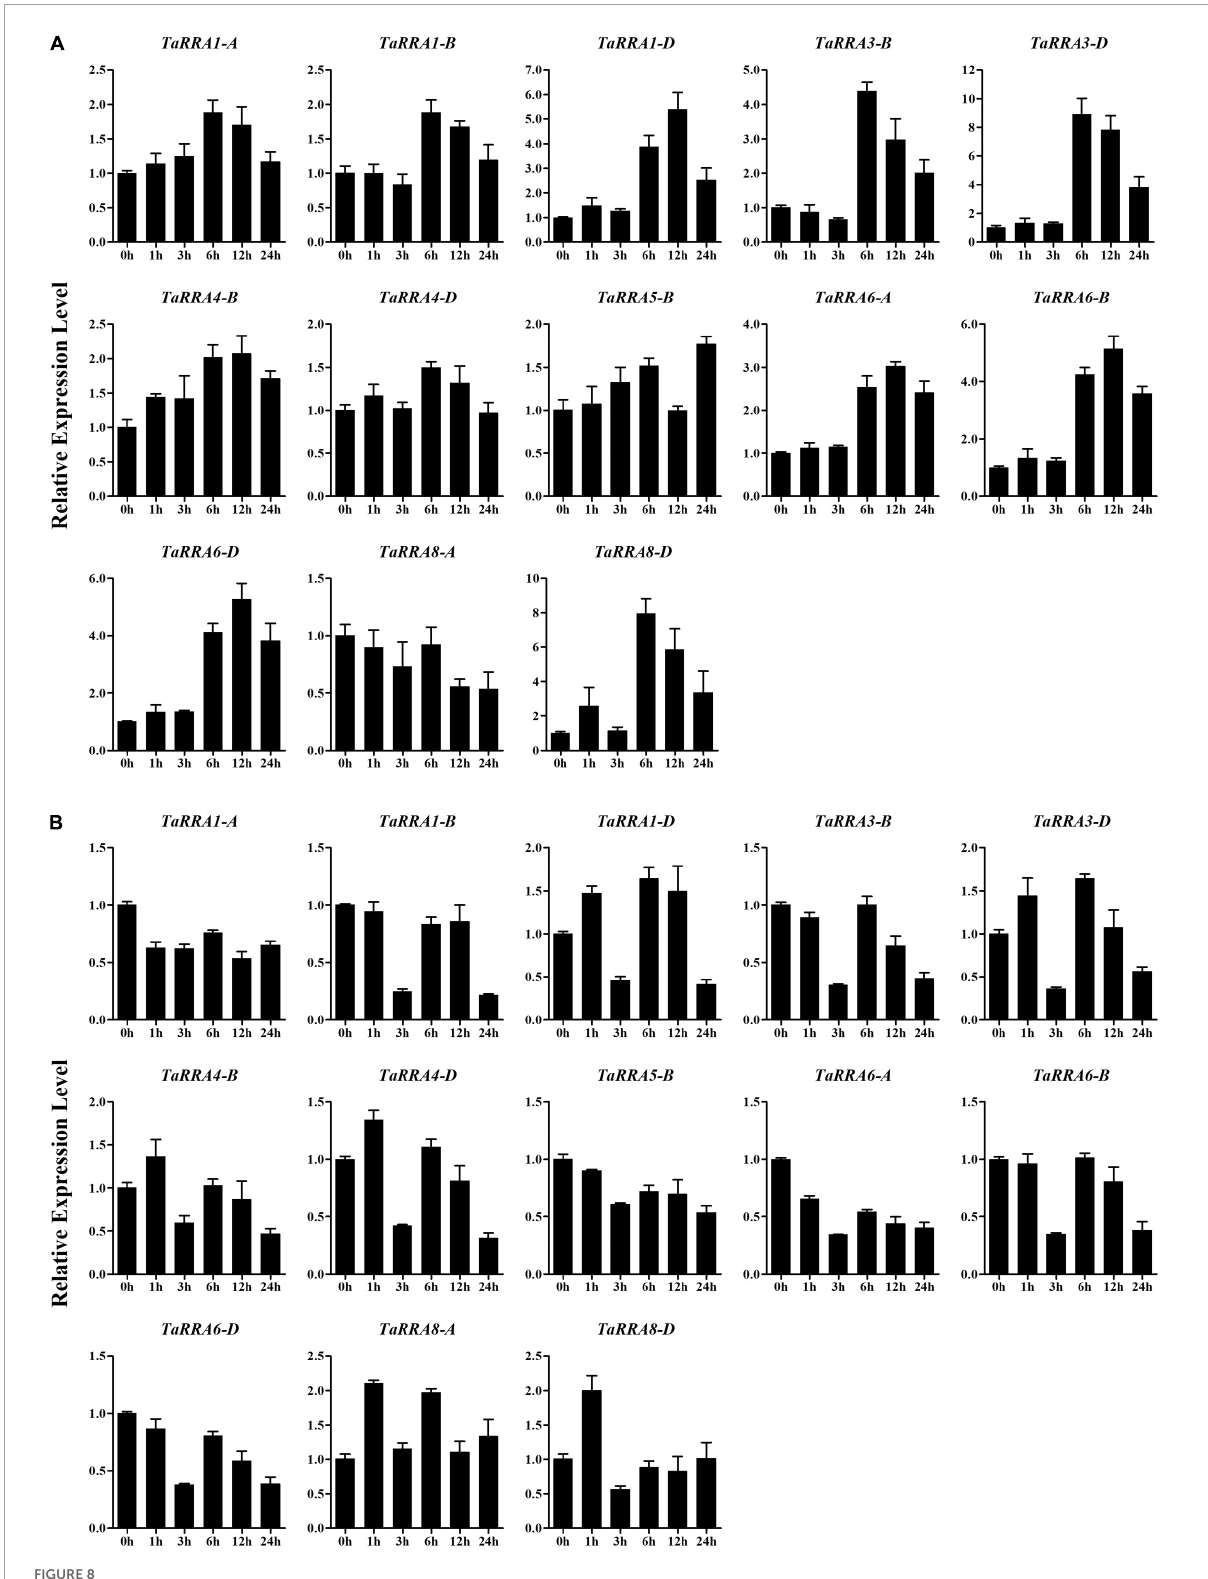
FIGURE8 Quantitative RT-PCR analysis of TaRRA genes under cold and heat stress. Roots of 10-day-old seedlings were sampled after 0, 1, 3, 6, 12, and 24 h cold stress (A) and heat stress (B) . The data are given as means ± SE of three biological replicates.